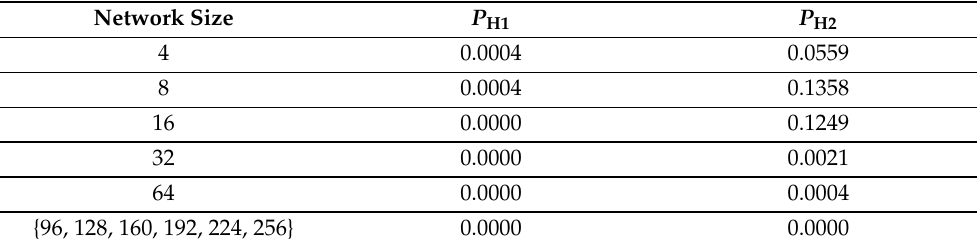
Table 3. Table of p values of null hypotheses for different network